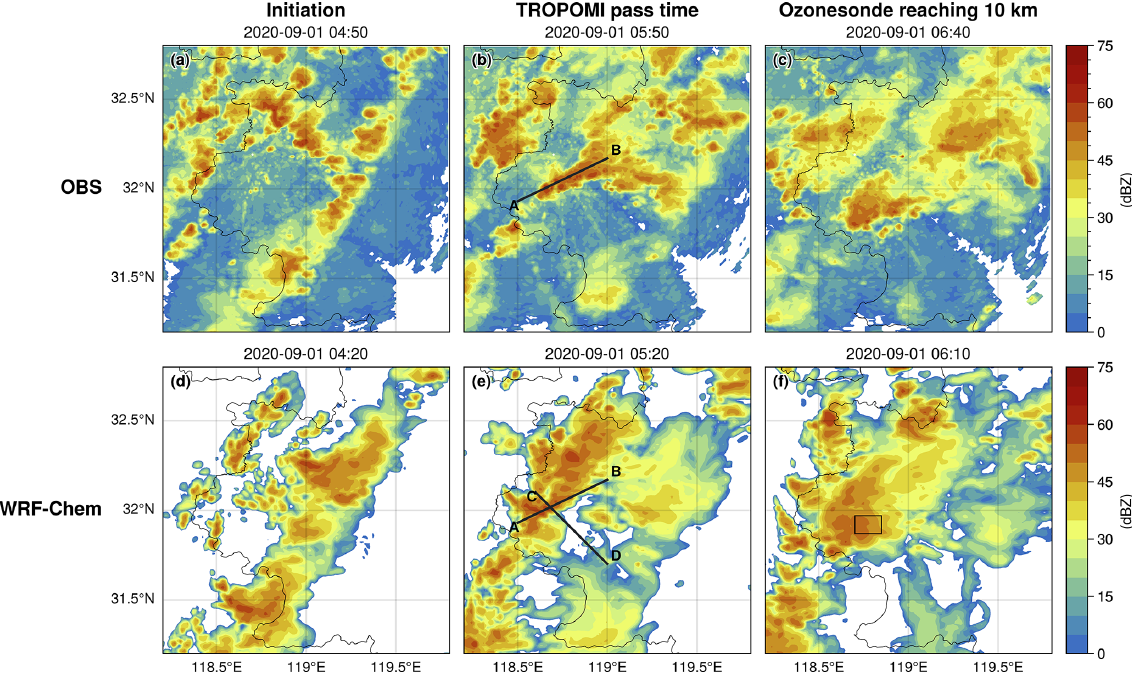
Figure 3. Same as Fig. 2 but for the case on 1 September 2020. The simulation time is 30min ahead of each radar